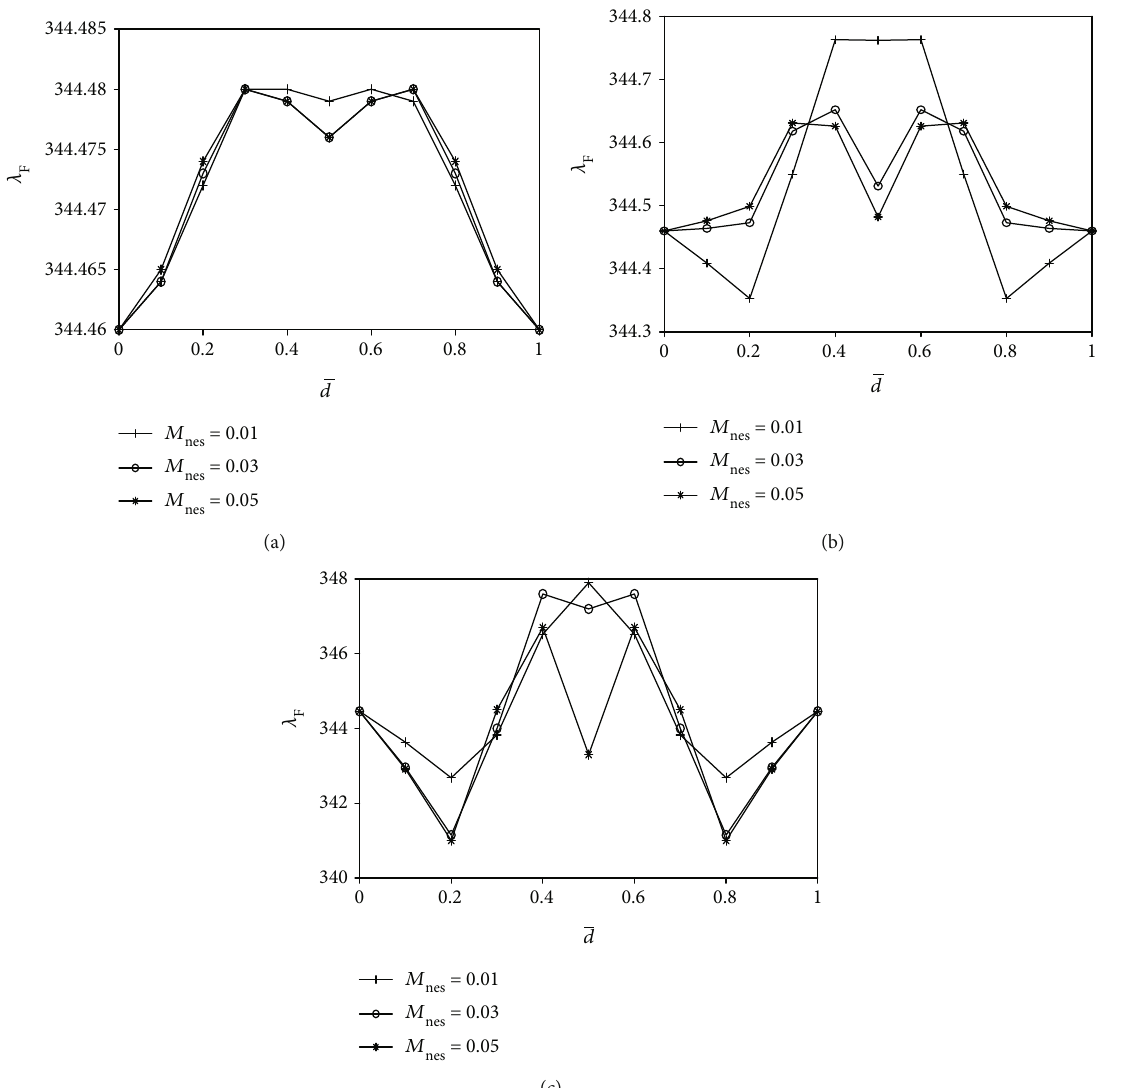
(cid:2) d Figure 2: E ff ects of M on the stability boundaries for di ff erent damping coe ffi cients: (a) C nes = 0 : 01 , (b) C nes = 0 : 1 , and (c) C nes = 1 nes and